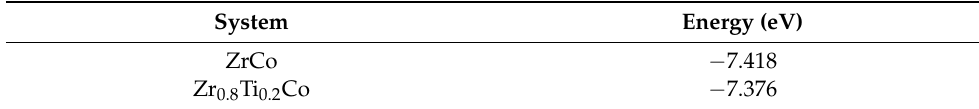
Table 4. Calculated cohesive energy of ZrCo and Zr 0.8 Ti 0.2 Co